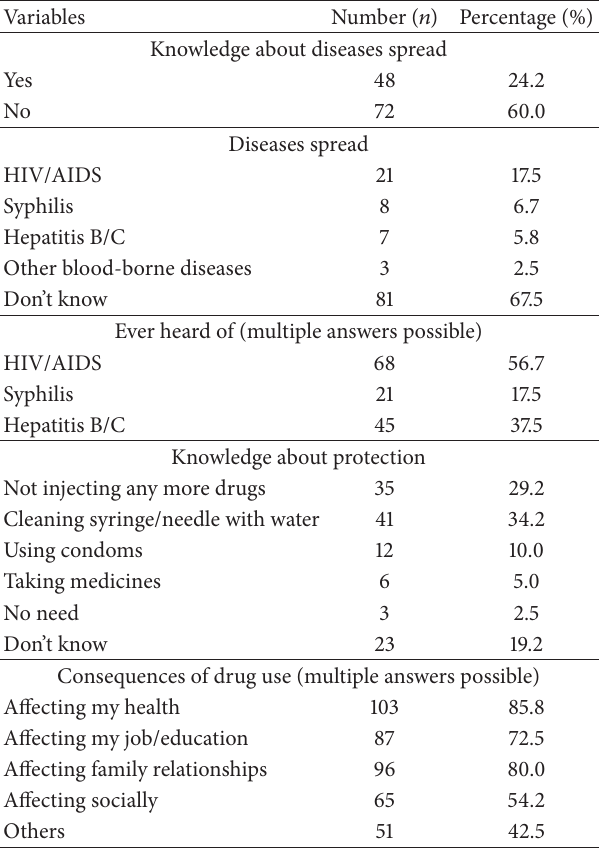
Table 4: Distribution of respondents by knowledge about diseases spread by drug use ( 𝑛 = 120 ).